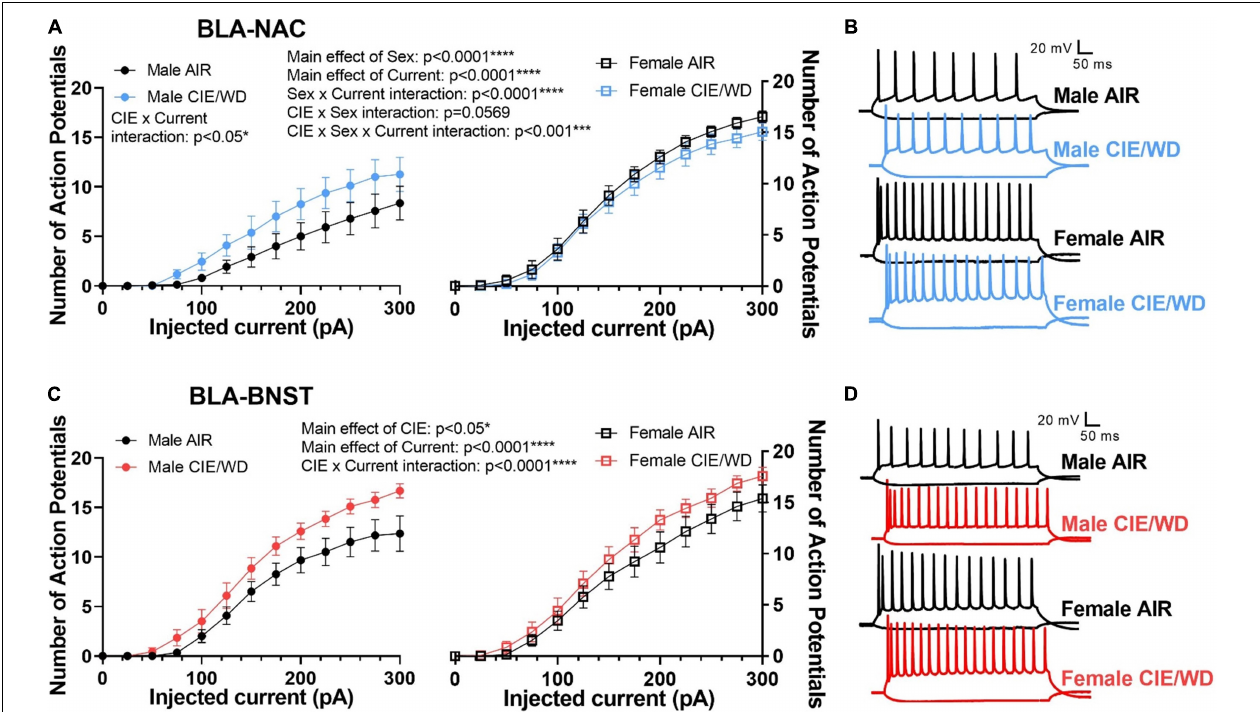
FIGURE 5 | CIE/WD enhanced excitability in BLA neurons during withdrawal when glutamatergic transmission was intact. (A) CIE/WD increased excitability in male BLA-NAC neurons ( p < 0.05; left) and females had higher BLA-NAC excitability than males ( p < 0.0001; right) (Males: n = 15 AIR, 11 CIE/WD; Females: n = 13 AIR, 14 CIE/WD). (B) Exemplar traces of 600-ms current steps of –100 and + 300 pA in BLA-NAC neurons from AIR males, CIE/WD males, AIR females, and CIE/WD females (top to bottom). (C) CIE/WD increased excitability in BLA-BNST neurons, regardless of sex ( p < 0.0001) (Males: n = 12 AIR, 11 CIE/WD; Females: n = 13 AIR, 14 CIE/WD). (D) Exemplar traces of 600-ms current steps of –100 and + 300 pA in BLA-BNST neurons from AIR males, CIE/WD males, AIR females, and CIE/WD females (top to bottom). Data analyzed by mixed-effects